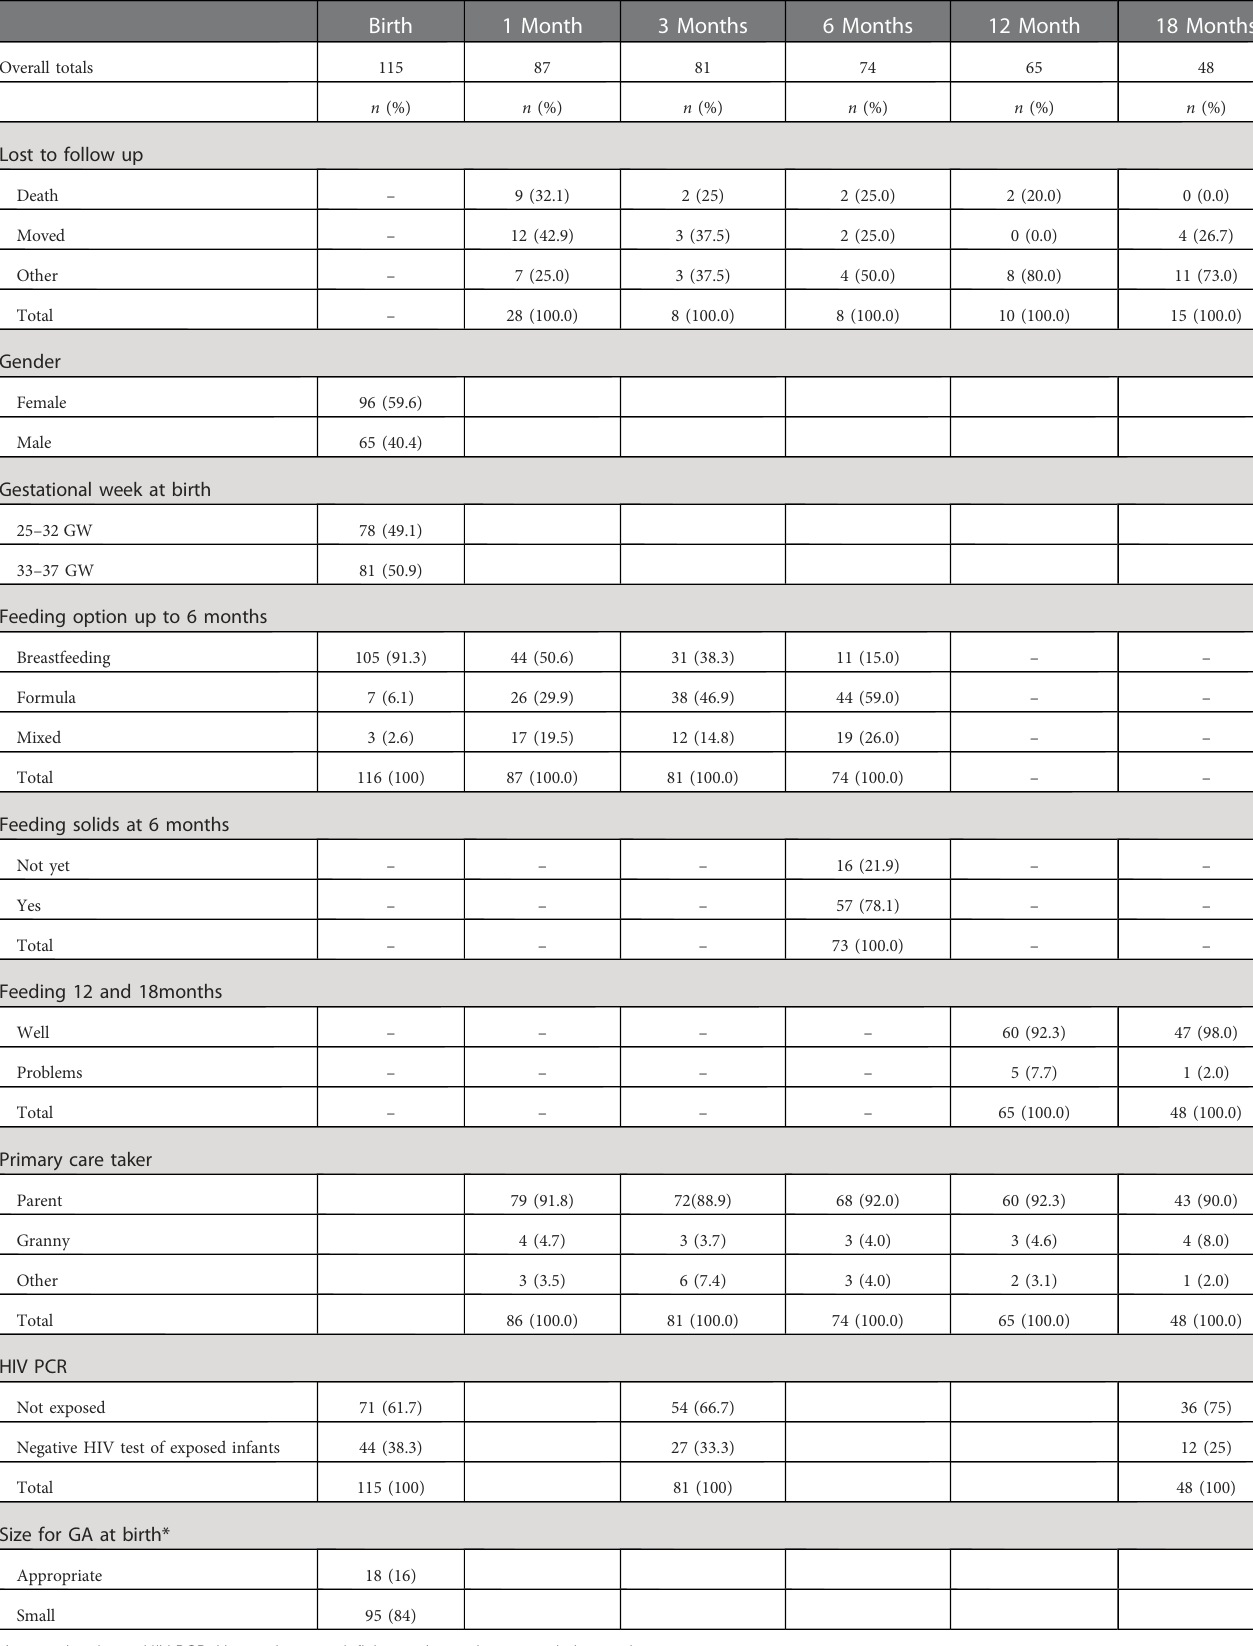
TABLE 1 Descriptive data of clinical and demographic